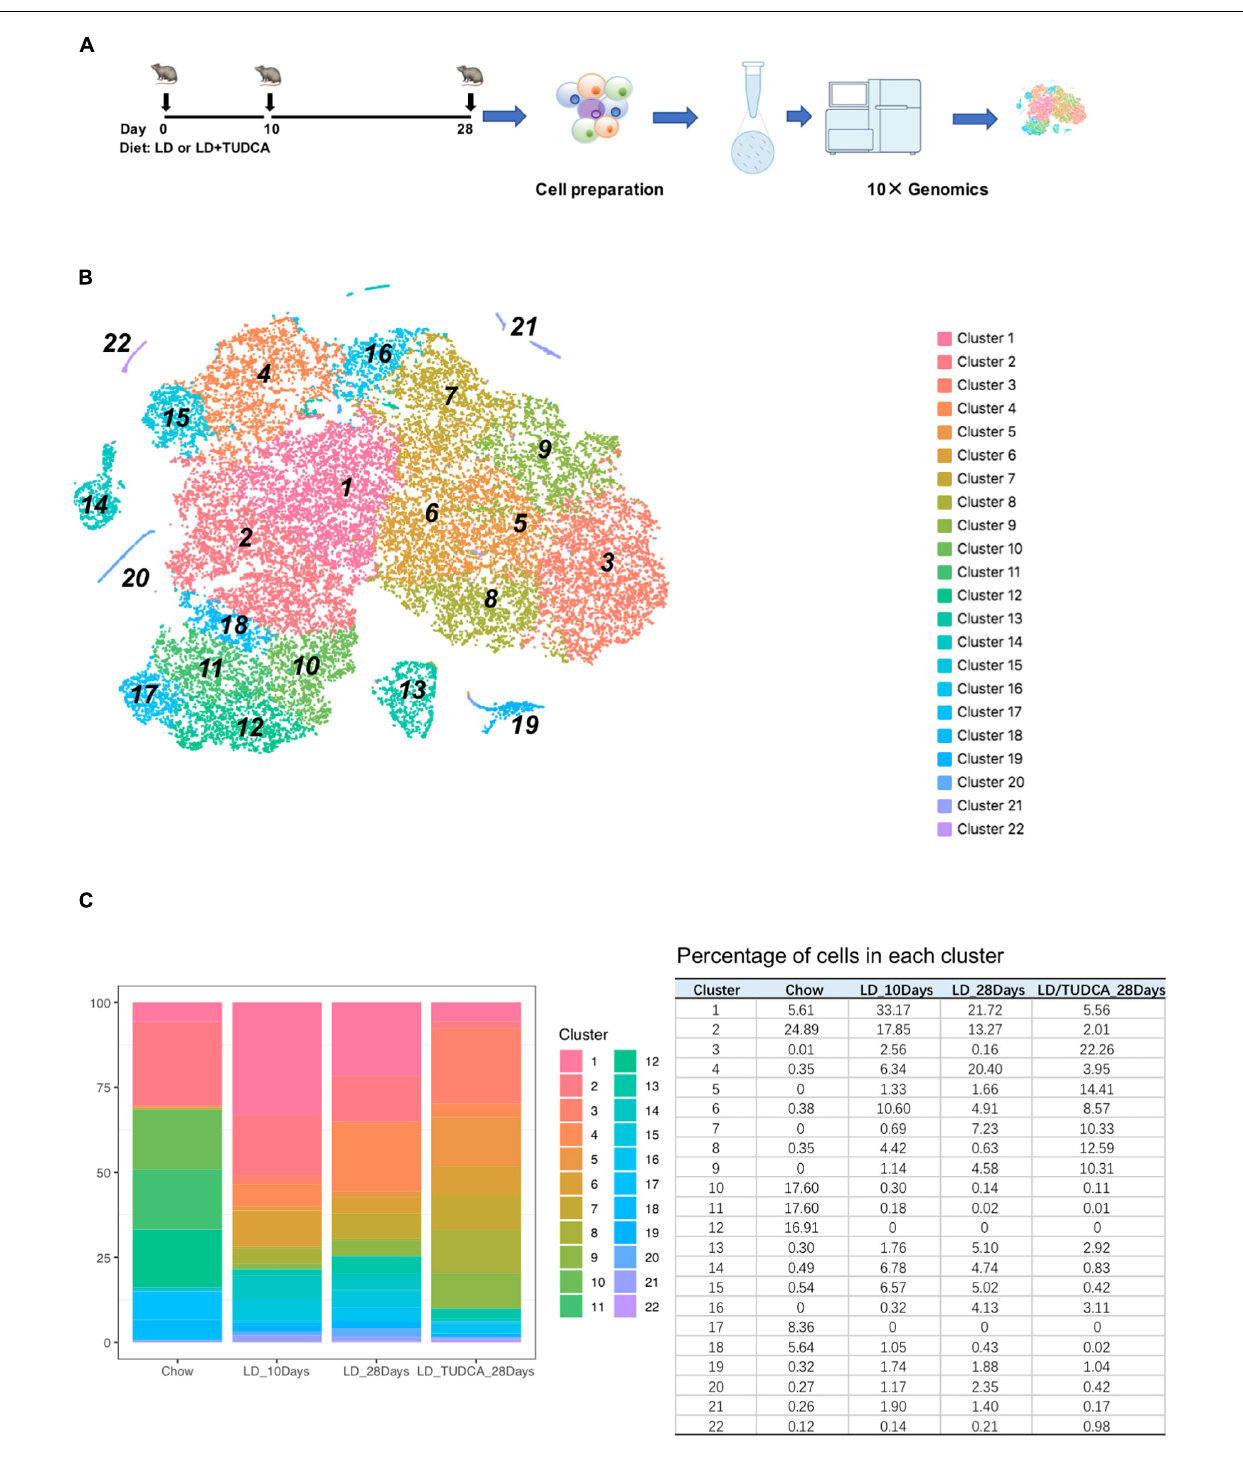
Frontiers in Cell and Developmental Biology |